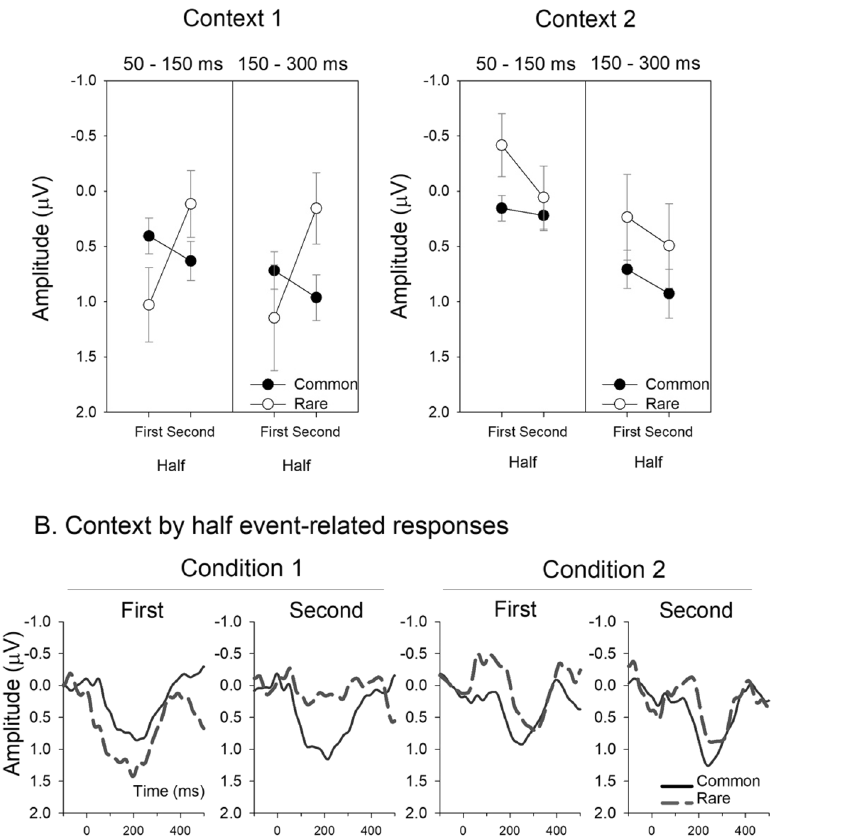
Figure 3. ( A ) Group mean amplitudes in the alternating context experiment over 50–150 ms and 150–300 ms from tone onset for the common and rare tone responses for context 1 (left) and context 2 (right) for the first and the second 2.1 min long periods within the context blocks. The error bars represent the standard error of the mean. ( B ) Group averaged event-related brain responses at Cz for the common and rare tones in context 1 (left) context 2